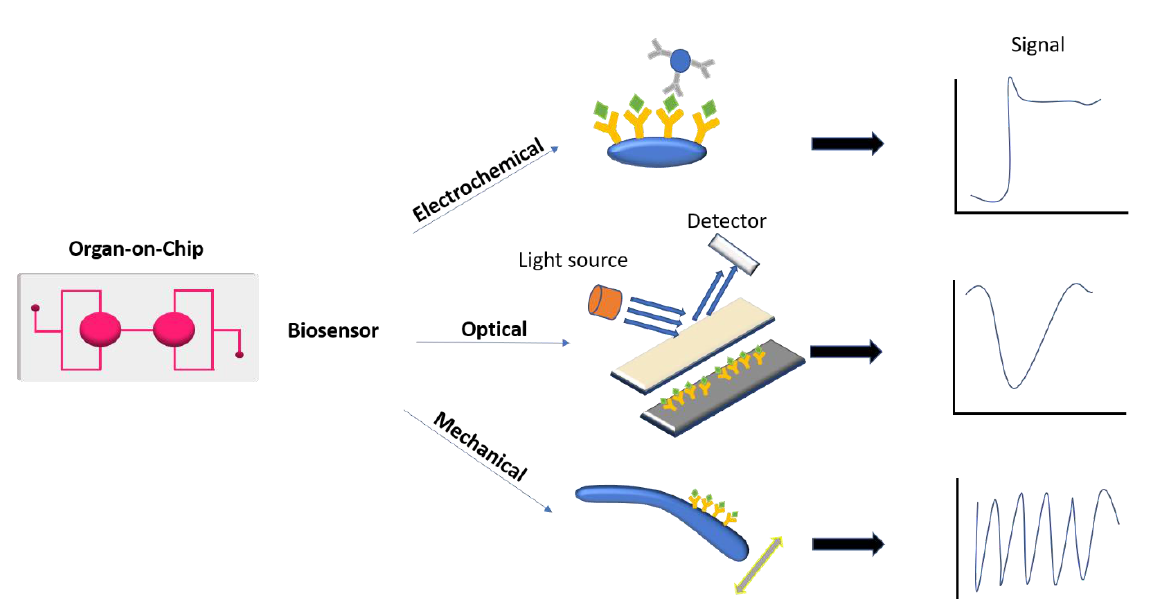
Figure 4. Examples of sensor platforms that can be integrated with organ-on-a-chip. Electrochemical biosensors measure the change of potential, current, conductance, or impedance induced by the immunoreaction. Optical biosensors determine the change in the optical properties of interaction between analyte and receptor. Mechanical biosensors assess the angular deflection due to molecular binding.